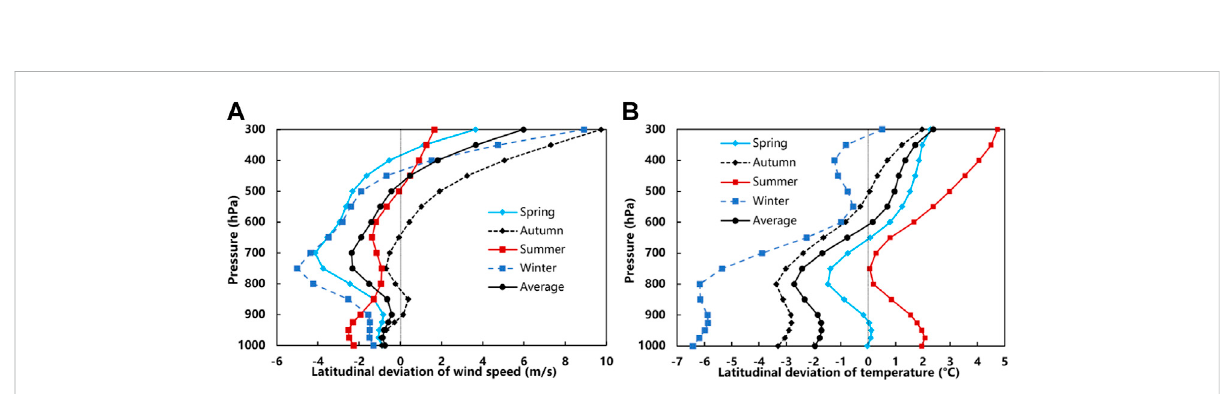
FIGURE 8 Overall and seasonal deviations of wind speed (A) and temperature (B) from the same latitudinal band for the period 1999 to 2010 in the range 104 ° E – 109 ° E and 28 ° N – 31 ° N (corresponding to the SCB